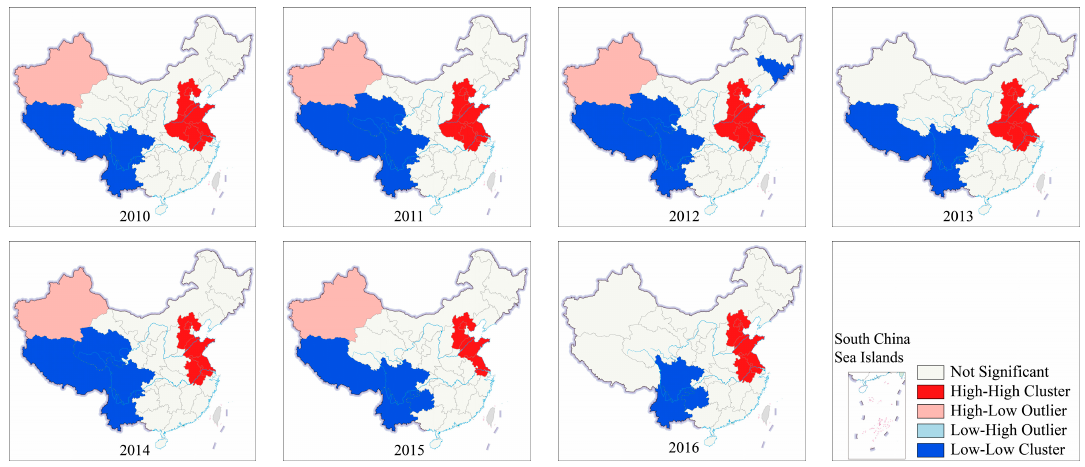
Figure 10. LISA cluster map of PM 2.5 concentration for 31 provinces, 1998-2016.